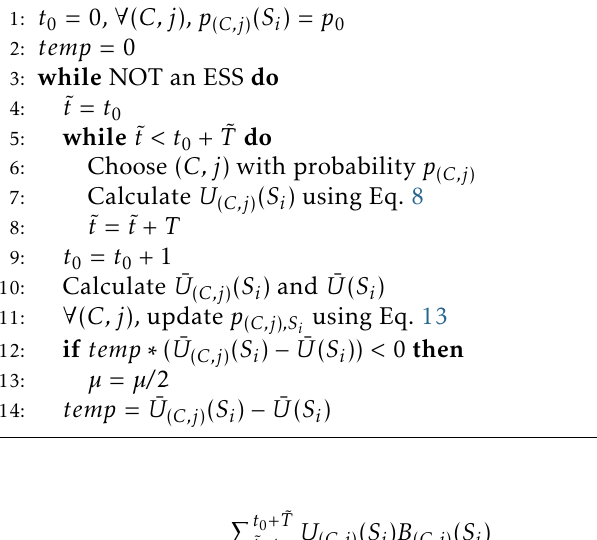
Algorithm 1 Evolutionary algorithm for S i